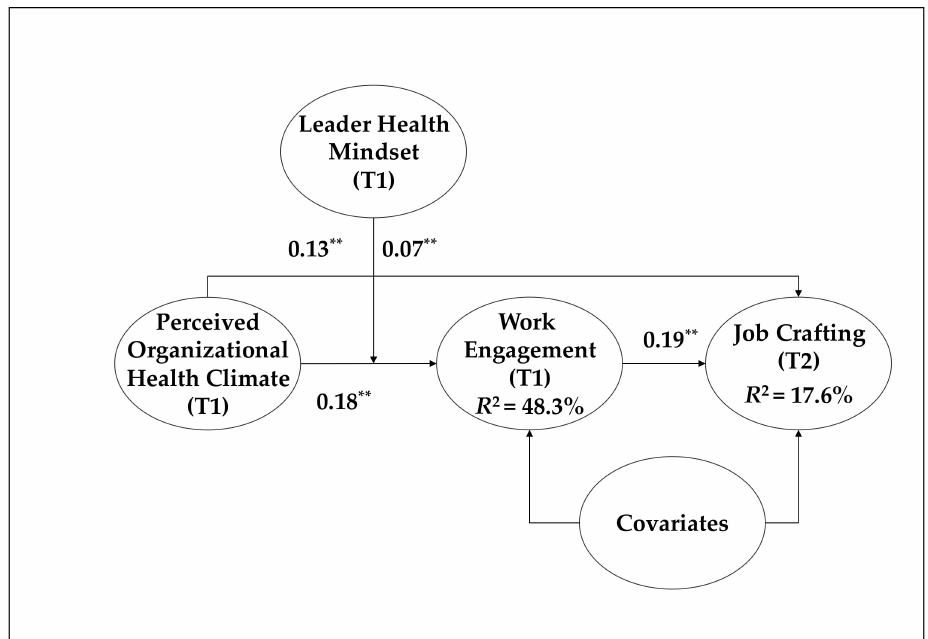
Figure 2. Summary of results; unstandardized coefficients were provided. For model parsimony, the results for the covariates (e.g., gender, age, job tenure, positive affectivity, and negative affectivity) were omitted. ** p <